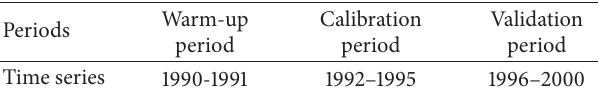
Table 2: The warm-up, calibration, and validation period for the